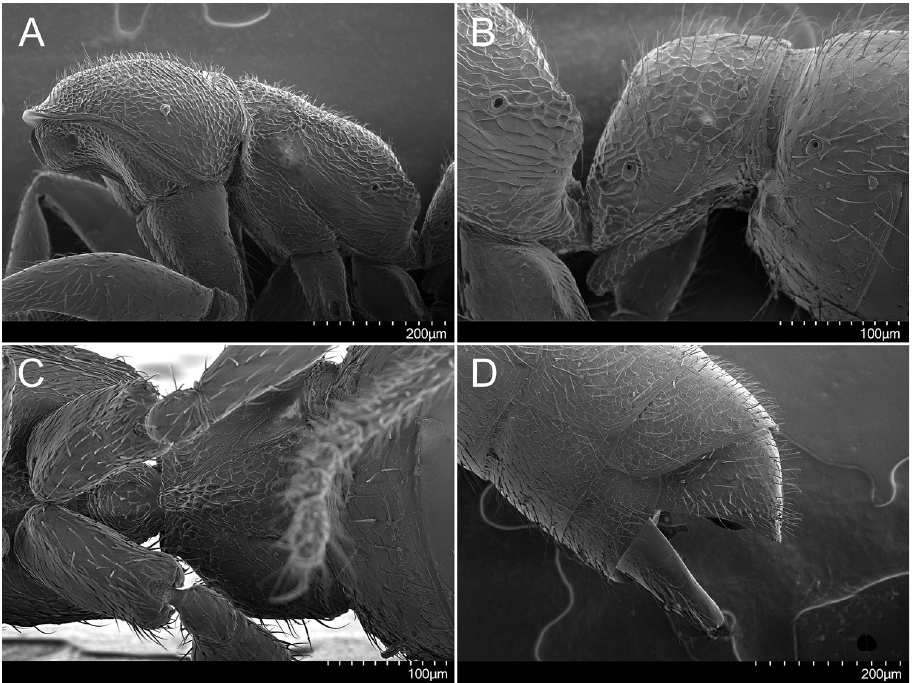
Figure 3. Holotype of Stigmatomma luyiae sp. n . (CASENT0922349); worker. Images by FAE; available at AntWeb.org. A Mesosoma, lateral view B Petiole, lateral view C Petiole, ventral view D Apex of the gaster, lateral